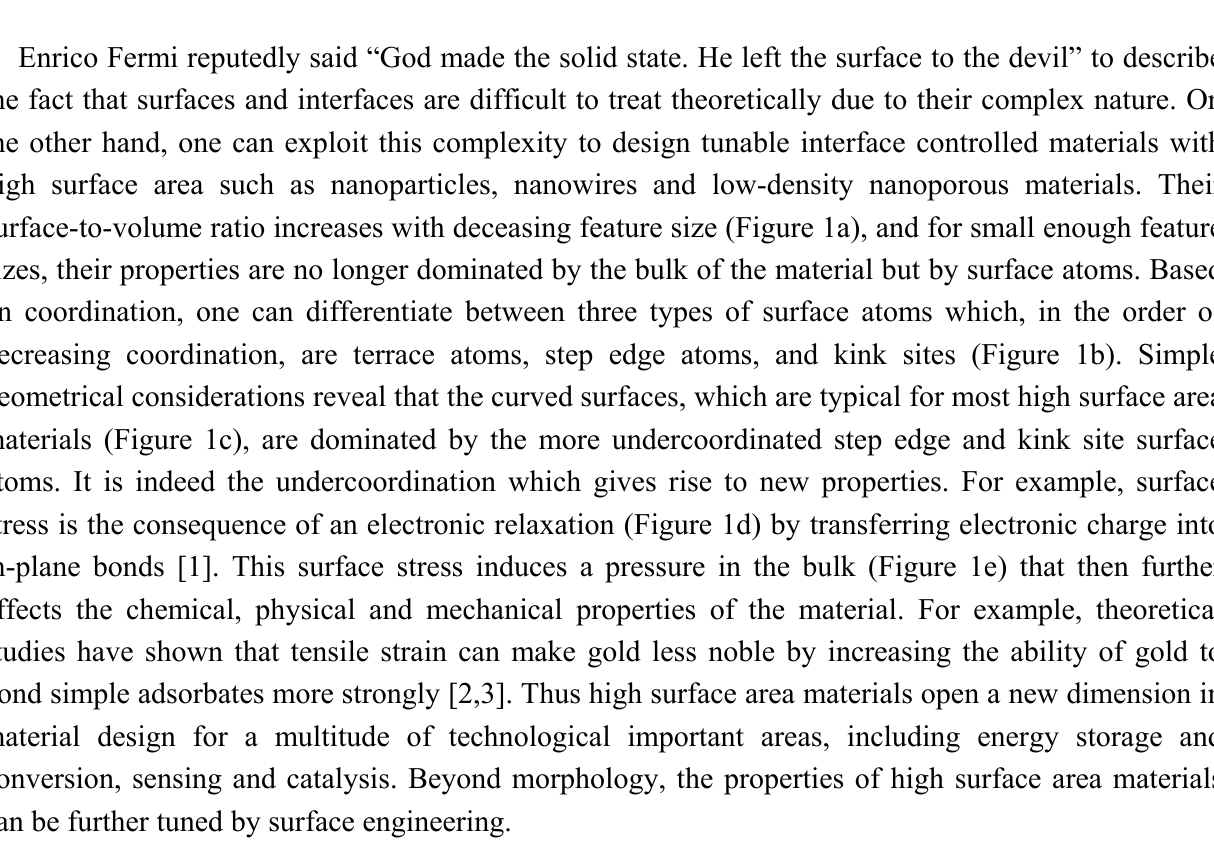
Figure 1. A characteristic property of high-surface area materials is their extremely high surface-to-volume ratio. (a) Typical percentage of surface atoms as a function of the internal length scale. (b) Illustration of terraces and steps for a single crystal surface. (c) Curved surfaces contain a high density of very-low coordination sites such as step edge and kink sites. (d) Surface stress owing to the reduced coordination of surface atoms causing charge transfer to in-plane bonds. (e) Schematic presentation of the origin of the surface stress induced pressure in nanostructured materials which easily can reach the GPa